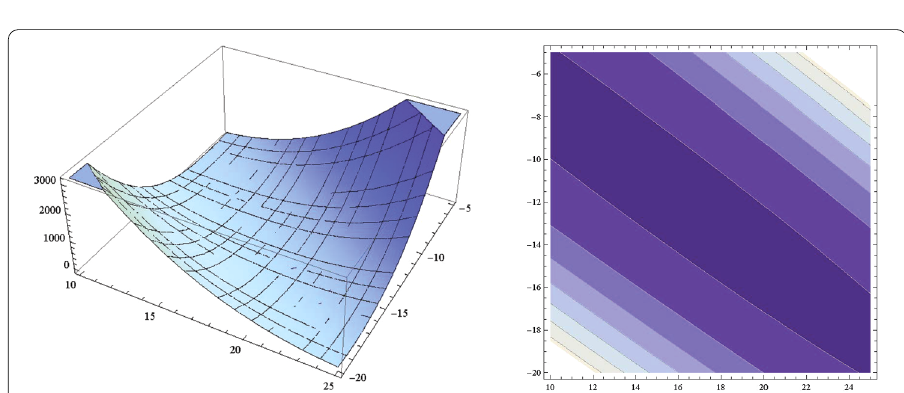
Figure 7 Graph of (cid:2) ( x ) and its contour for Example 3 around x 2